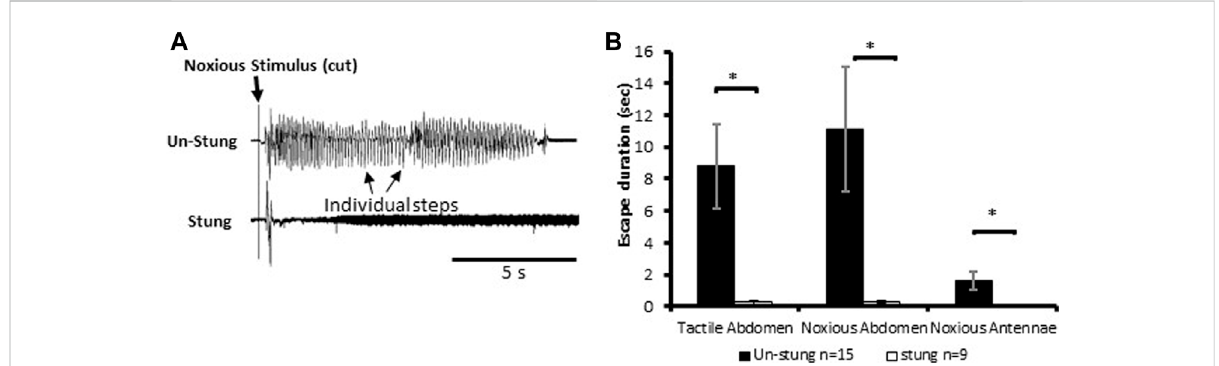
Noxious stimulus does not induce a typical nocifensive escape response in stung individuals. (A) Leg movements (individual steps, which represent escape) of un-stung (upper trace) and stung (lower trace) cockroaches in response to a manual noxious abdominal stimulus. Stimulus onset is indicated with a vertical line. (B) The escape duration of stung cockroaches is signi fi cantly lower than that of un-stung cockroaches in response to all types of stimuli. Bars represent means ± SEM, signi fi cance is indicated with an